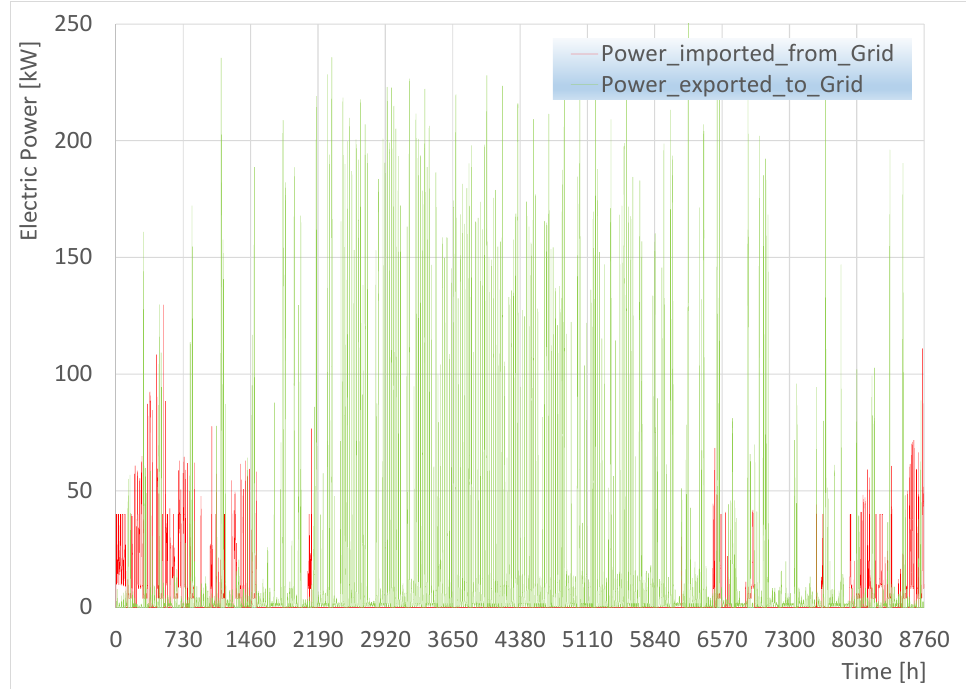
Figure 16. Power levels that were imported or exported to the electricity grid in the course of the year (charging the employees’ EVs during the day).